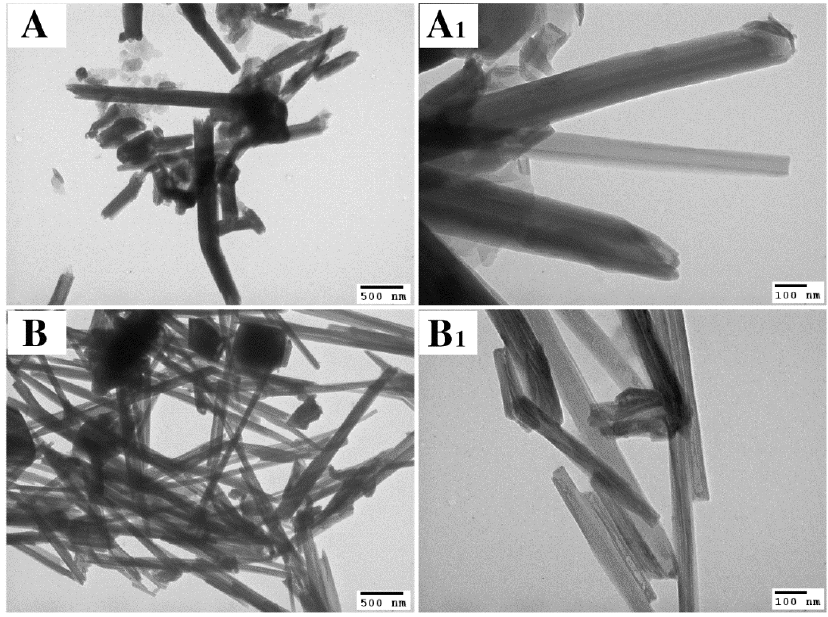
Figure 6. TEM images of the UPS ( A , A 1 ) and LOS ( B , B 1 ) sample. Scale bar in ( A , B ) images represents the length of 500 nm and in ( A 1 , B 1 ) images is 100 nm.